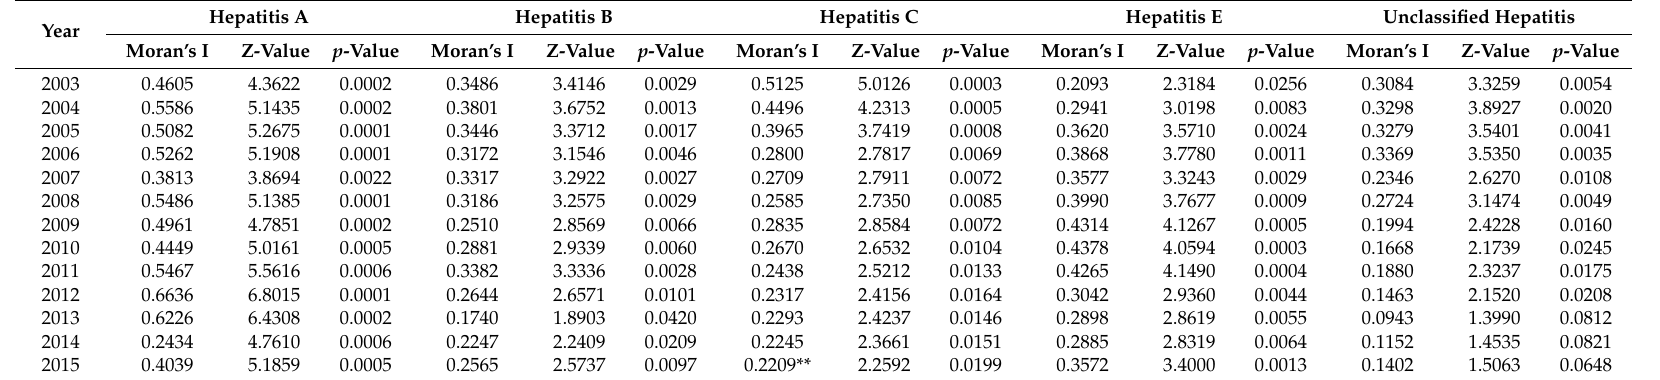
Table 2. Global spatial autocorrelation analysis and test results 2